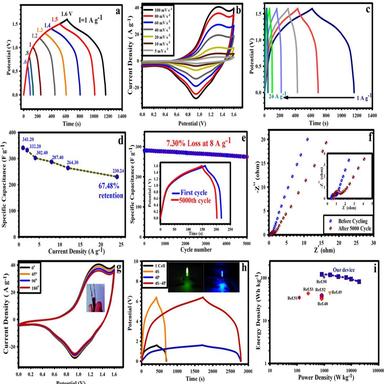
Electrochemical performance and application of the NiGa2S4-rGO/NF//FeSe2-rGO/NF FSASC device. (a) CD curves of the FSASC at various potential windows at 1 A g1 . (b) CV curves of the FSASC at various scan rates. (c) The FSASC's galvanostatic charge/discharge curves at various current densities. (d) Rate capability of the FSASC. (e) Longterm cycling stability of the FSASC over 5000 CD cycles at the current density of 8 A g1 . (f) Nyquist plots of the FSASC before and after cycling. (g) The FSASC's CV curves